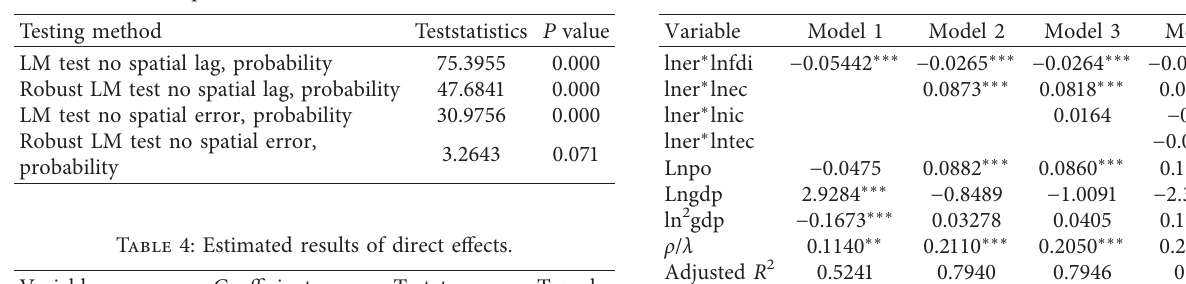
Figure 1: Moran scatterplots of environmental regulation and carbon emissions in 2003, 2009, and 2017. Table 3: Comparative results of SLM and SEM Model. Table 5: Estimated results of indirect